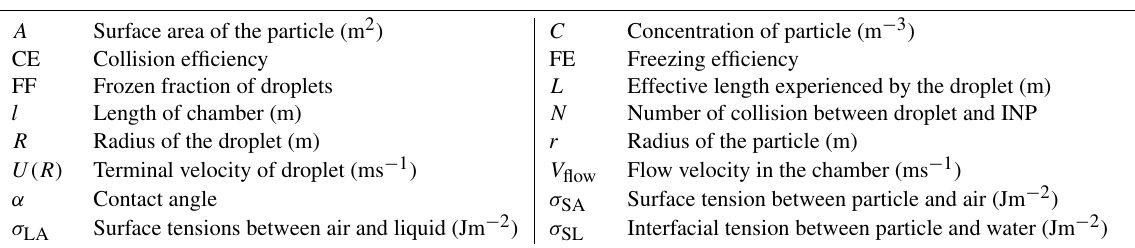
Table A1. List of